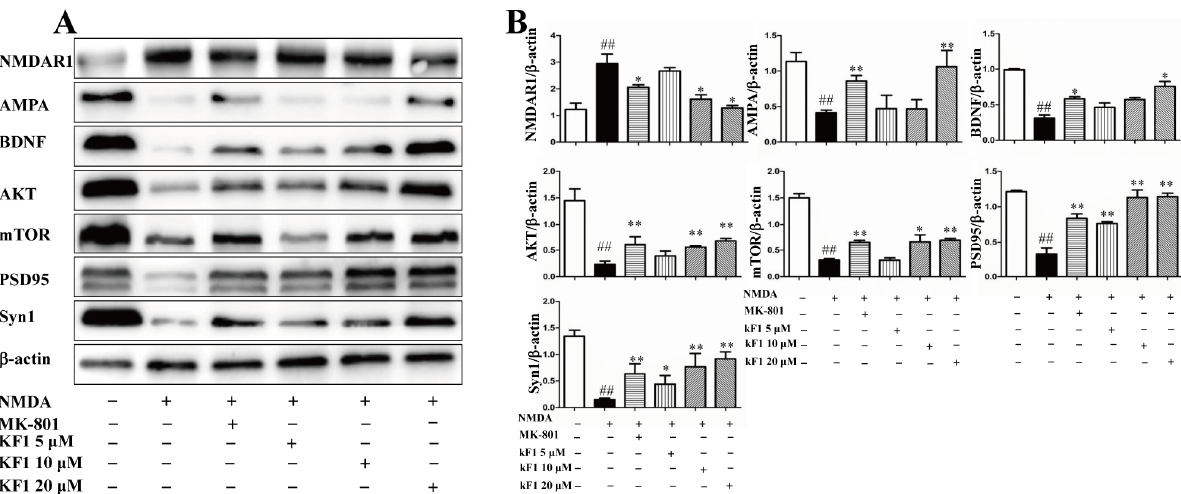
Figure 8. Effect of KF1 on the expression of related proteins in the PC12 cells. ( A ) Related protein expression; ( B ) quantitation of interacting protein levels in the PC12. The relative optical density was normalized to β -actin. The data are expressed as means ± SEM ( n = 3). # p < 0.05, ## p < 0.01 versus vehicle group; * p < 0.05, ** p < 0.01 versus NMDA group.